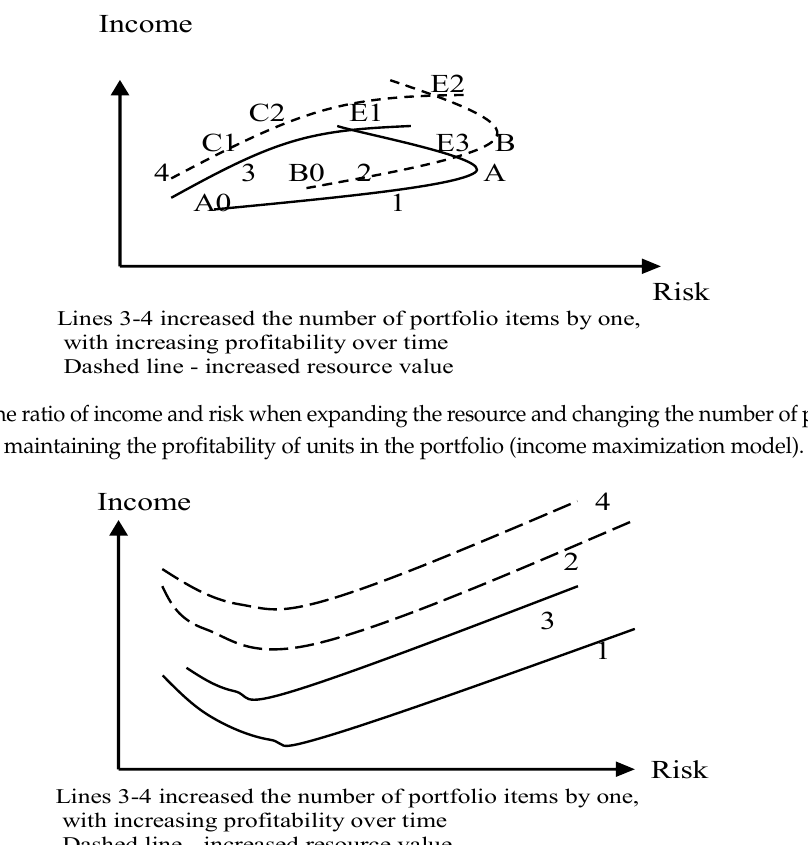
Figure 8. The ratio of income and risk when expanding the resource and changing the number of portfolio objects, while maintaining the profitability of units in the portfolio (income minimization model).